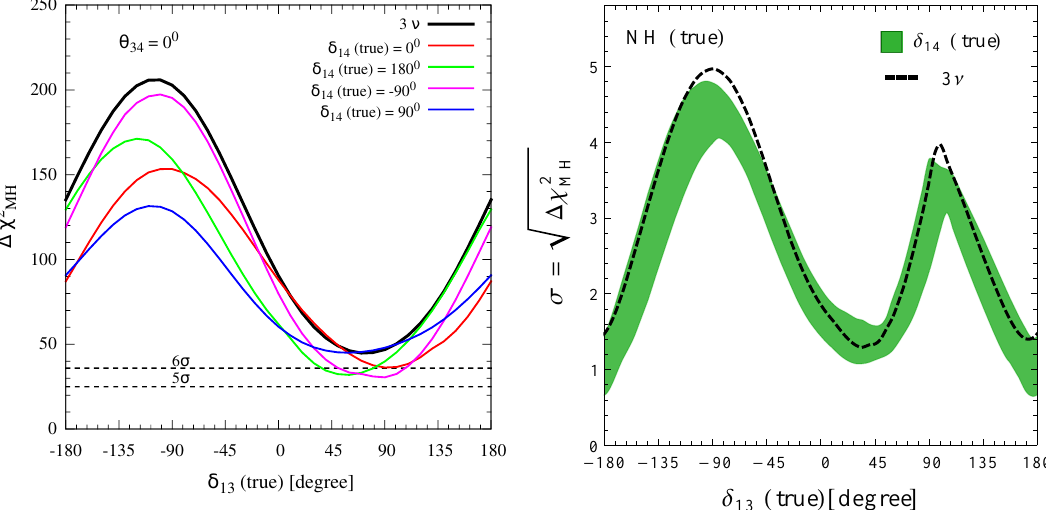
Figure 2. Discovery potential of DUNE (left) and T2HK (right) for identifying the correct hierarchy (NH) as a function of true δ 13 . In both panels, we have fixed true and test θ 14 = θ 24 = 9 ◦ and θ 34 = 0. In both panels, the black curve represents the 3-flavor case. For DUNE (left), in the 3 + 1 scheme, we provide the curves for four different values of true δ 14 marginalizing over test δ 14 . For T2HK (right), the green band is obtained by varying the true value of δ 14 in the range [ − π , π ] and marginalizing the test value of δ 14 in the same range. Figures taken from [45] ( left ) and [50] ( right